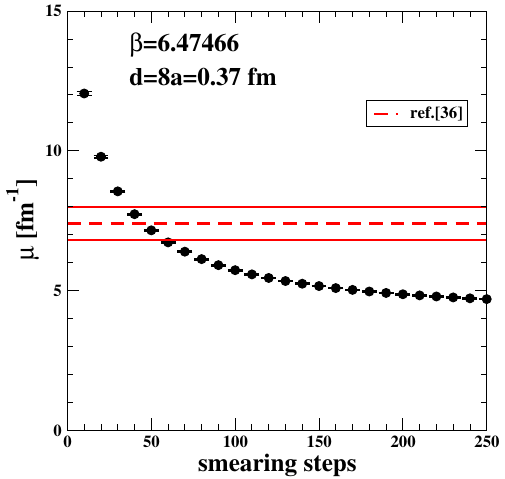
Fig. 9 The Clem μ parameter (full black circles) versus smearing at β = 6 . 47466 and d = 8 a (cid:9) 0 . 37 fm compared to the value obtained in Ref. [36] (the red dashed line is the central value, the red full lines delimit the error band)